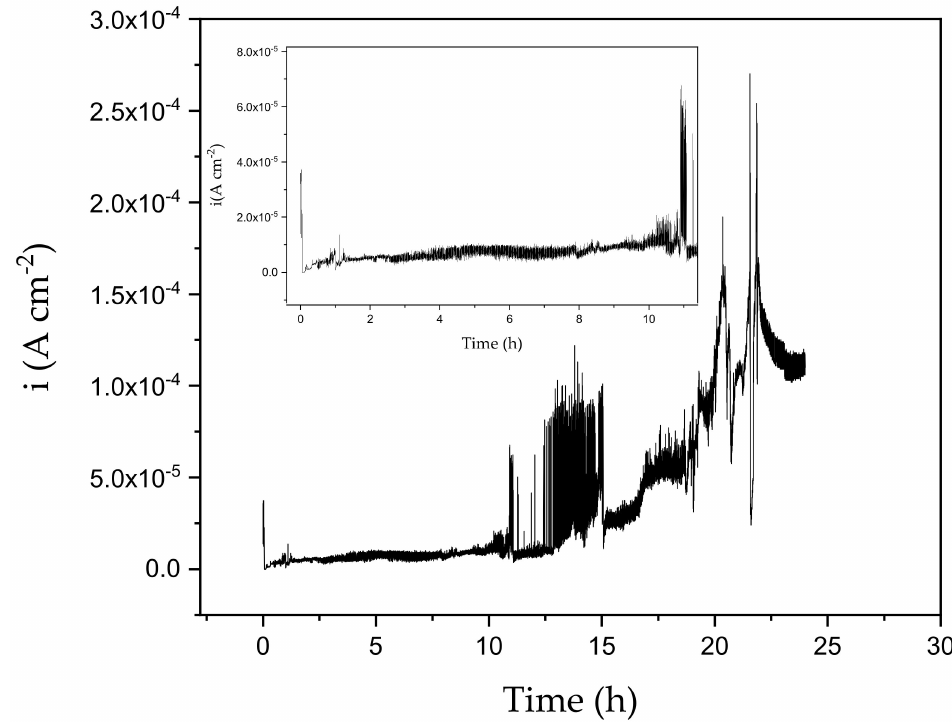
Figure 7. Current density as a function of time for AA2024 coated with a copolymer with 13.4% octyloxy units, polarized at 0 V vs. SCE in naturally aerated near-neutral 0.6 M NaCl solution, duration: 24 h. Inset: Magnification of the first 12 h.